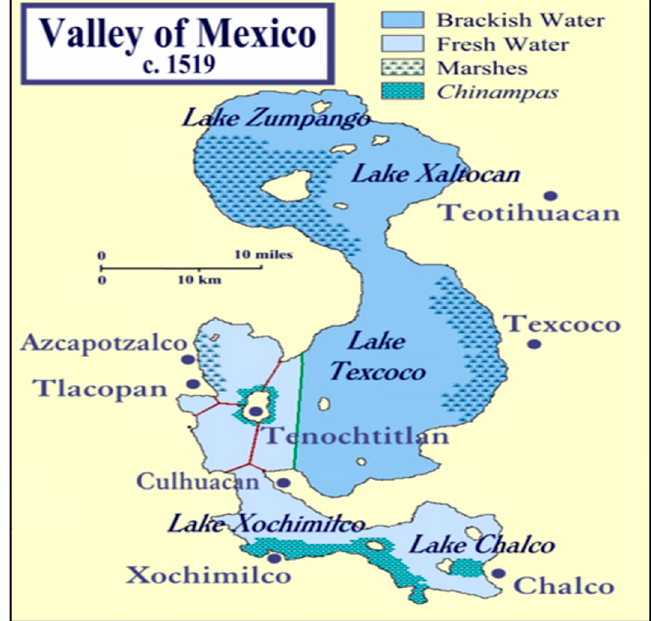
Figure 14. Lakes of Mexico Valley at the Aztec time, with areas occupied by the chinampas (adapted from [107]).